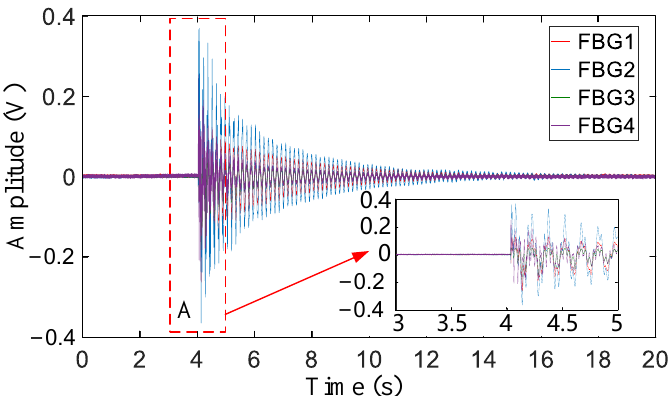
Figure 6. Impact signal after removing the DC component.